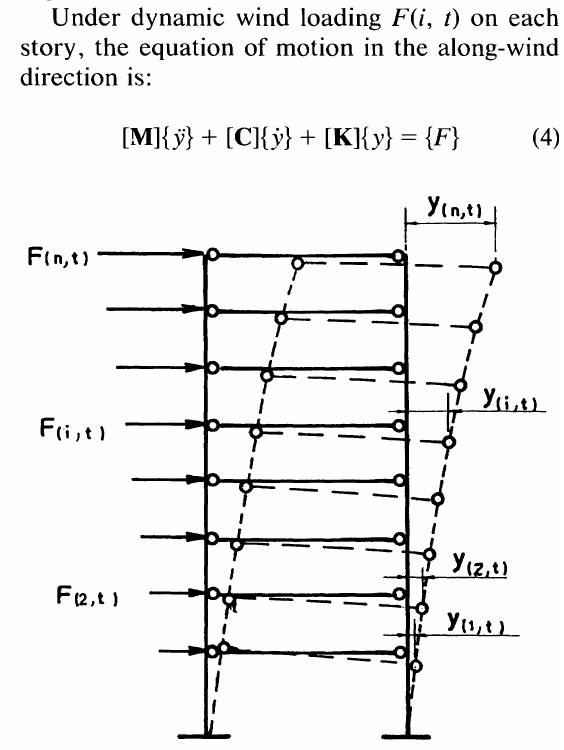
FIGURE 1 Analysis model of tube-in-tube